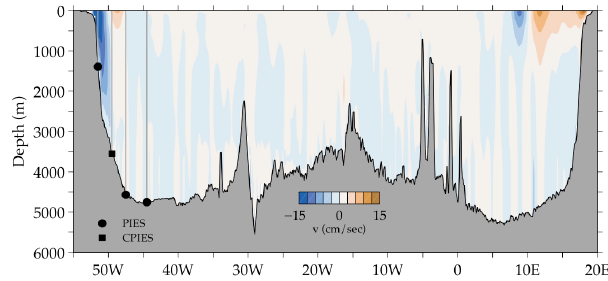
Fig. 3. Contour plot of the OFES model record-length (27-yr) mean Figure 3: Contour plot of the OFES model record-length (27-year) mean meridional meridional velocity, with oranges indicating northward flow and velocity, with oranges indicating northward flow and blues indicating southward flow. Also shown are the nominal locations of the PIES/CPIES deployed in the pilot array on blues indicating southward flow. Also shown are the nominal lo- the western boundary. Model (OCCAM) 1/10 degree bottom topography is shown in cations of the PIES/CPIES deployed in the pilot array on the west- gray. ern boundary. Model (OCCAM) 1 / 10 degree bottom topography is shown in gray.